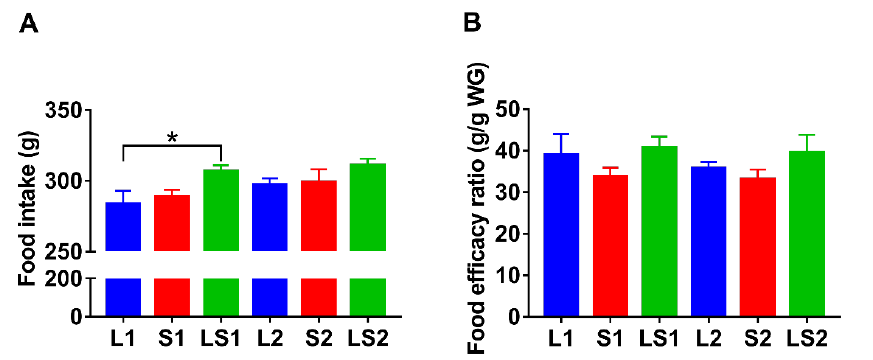
Figure 2. Impacts of various oil/fat diets on ( A ) food intake, ( B ) food efficacy ratio, during a period of 16-week intervention. “*”represents significant differences at p < 0.05.